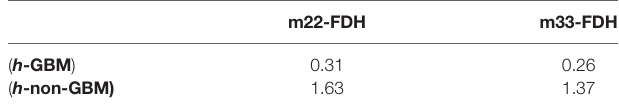
TABLE 2 | The average peak values ( h ) of FDH distributions of GBM and non- GBM